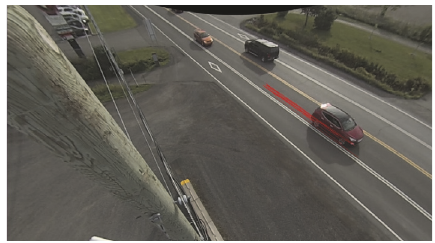
Figure 2: Feature tracking process by Traffic Intelligence .